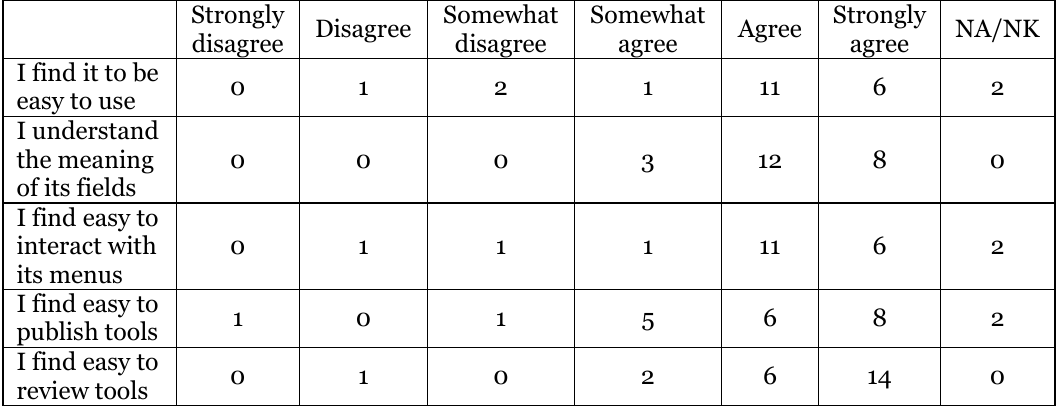
Results of the Questionnaire Related to We-Share Publication Usability